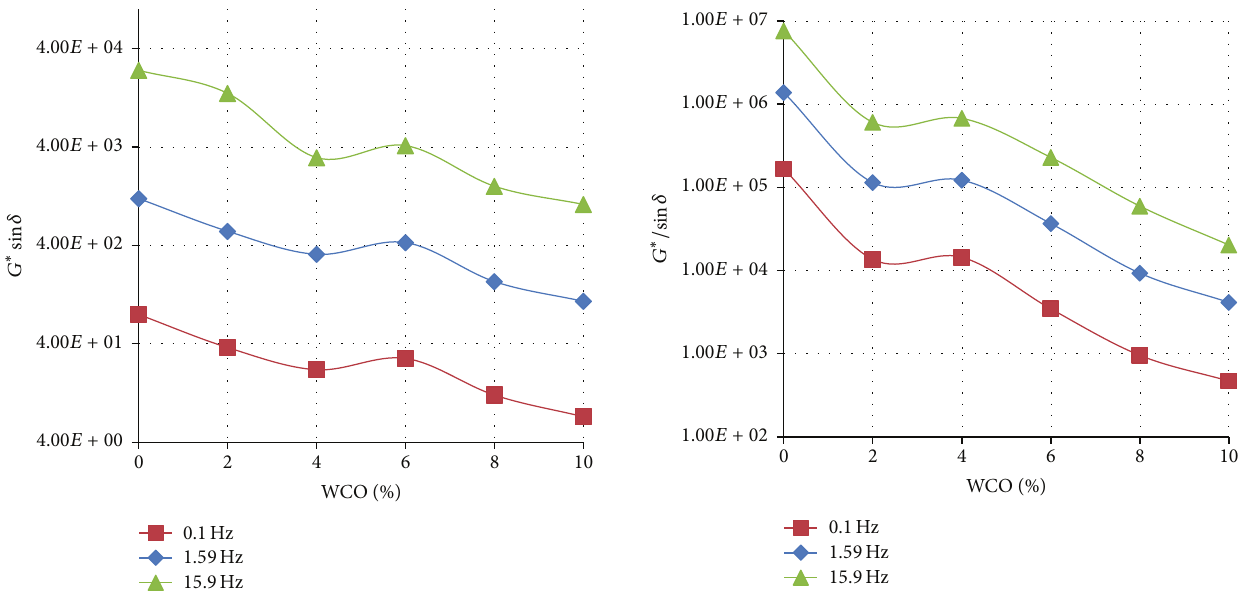
Figure 2: The variation of the fatigue cracking resistance parameter ( 𝐺 ∗ sin 𝛿 ) with increasing concentration of WCO in TPB at various oscillating frequencies at 60 ∘ C.